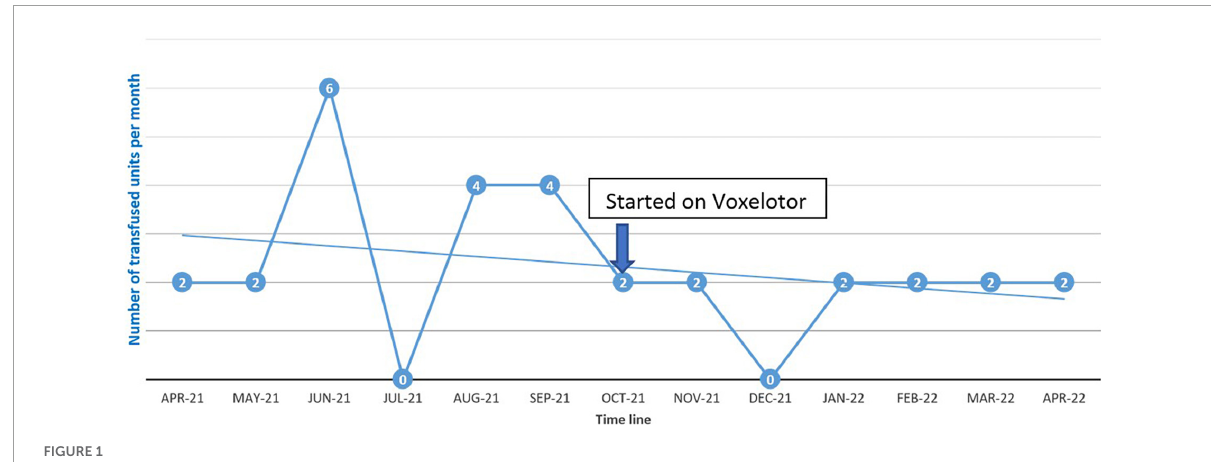
FIGURE1 Transfusion requirement before and after starting